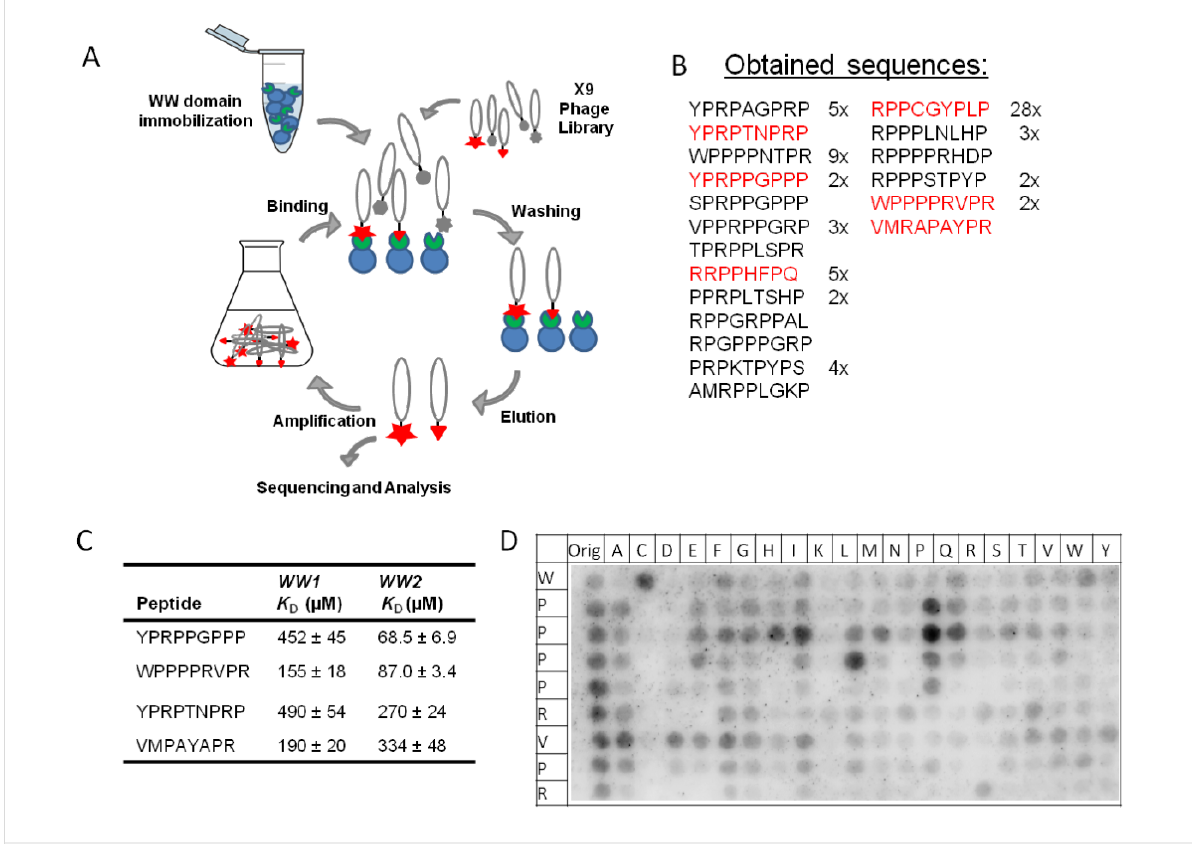
Figure 1: Phage display was used to find an optimized binding partner for FBP21-tWW. A) Schematic representation of the phage display workflow: FBP21-tWW is immobilized and incubated with an X9 phage library. Unbound phages are washed away, then phages expressing a binding peptide are eluted and amplified to create an enriched library, which is then subjected to another round of panning. Phages were sequenced after 3 and 4 rounds of panning. B) Sequences and frequencies of peptides obtained from eluted phages. Shown in red are the peptides which were chosen for further analysis. C) Six peptides representing different groups of binding peptides were synthesized and interactions were analyzed using ITC. Shown are the peptides for which K D values could be determined. D) A substitution analysis showed that in the binding motif of the peptide WPPPPRVPR, P5 and R9 most strongly contribute to binding of both WW domains. Shown here is the substitution analysis for WW2, the corresponding substitution analysis for WW1 is shown in Figure S1 (Supporting Information File